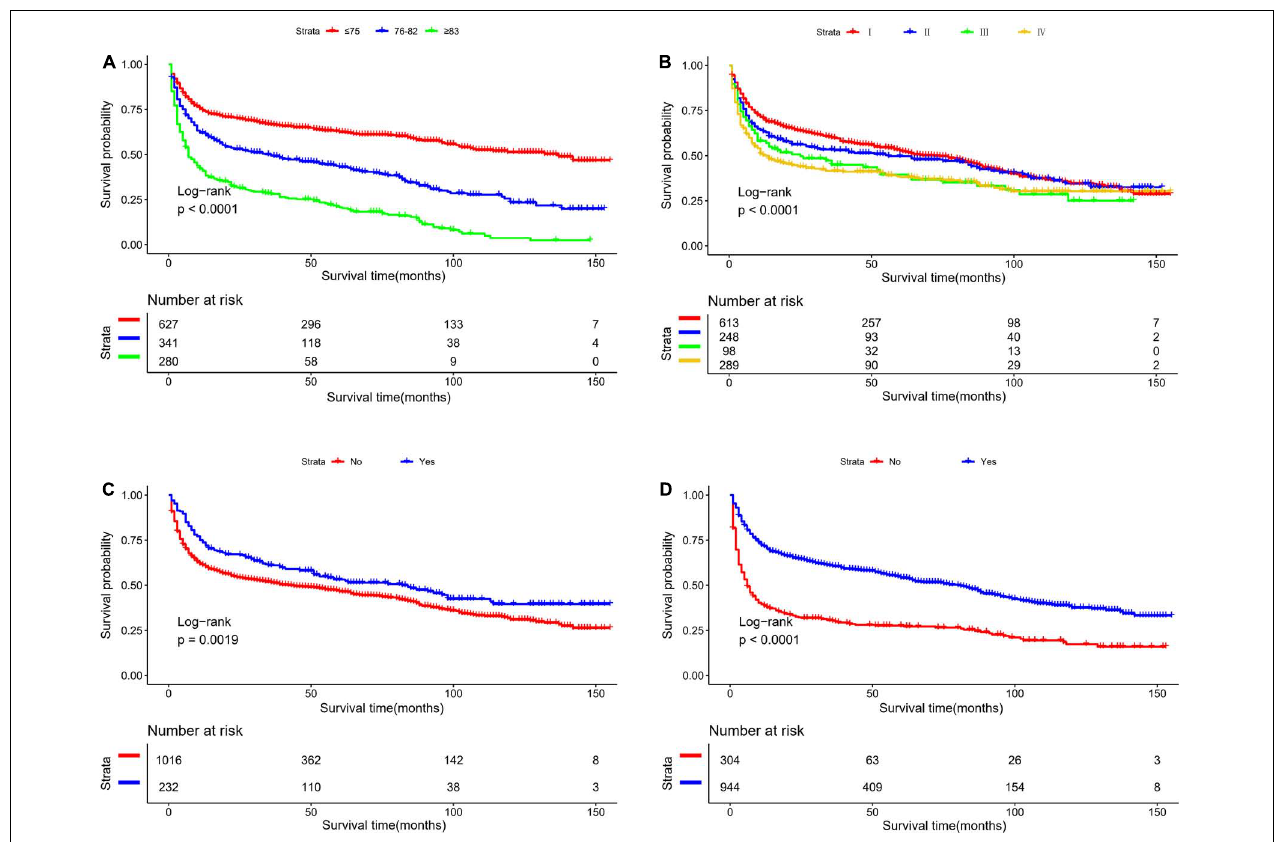
FIGURE 1 | Kaplan-Meier survival curves for overall survival in the development cohort, as stratified by (A) Age, (B) stage, (C) radiation, (D)